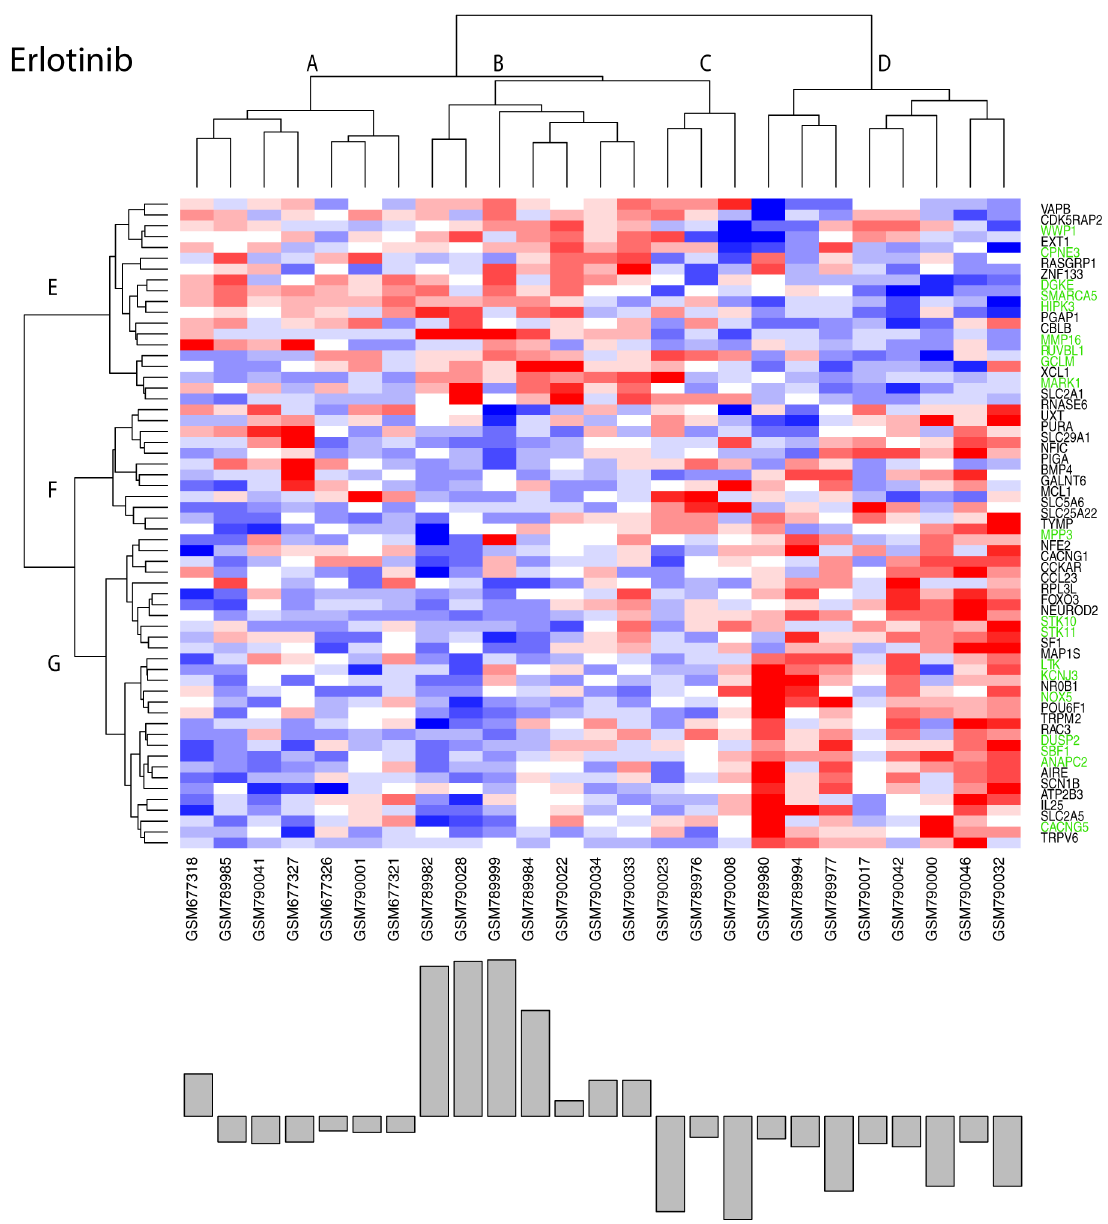
Fig 8. Clustered (Euclidean distance metric, Wards linkage) plot of 59 gene expressions (top panel) selected from genes in the GSEA pathways that have statistical significance (p < 0.2) when comparing the top and bottom 20 th percentiles of patient responses or have a significant (p < 0.2) correlation with the response data and are found in the upper 40 th percentile of pathway fitness. Expressions are coloredspectrallyfrom blue (under expression) to red (over expression). Bottom panel represents patient responses, orderedaccordingto the clusteredgenes. Student’s t-test comparing patient responsein clades A and B to clades C and D has a significancescore of 5.57e-4.Green labelsat the right edge identify genes contributing the most to pathwayfitness scores (cf. Table 1